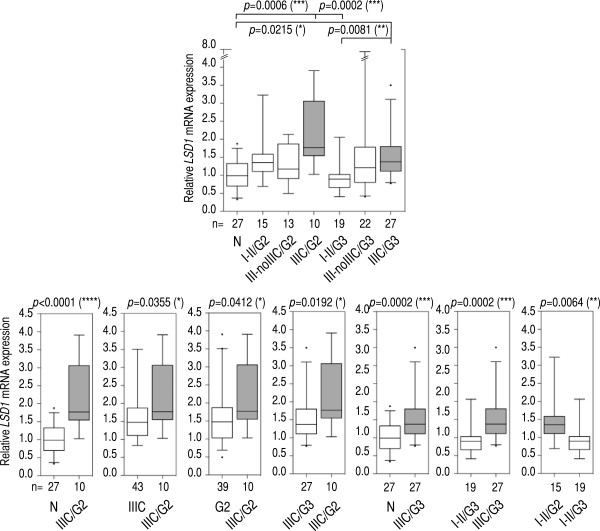
Multi- and pair-comparison statistical tests suggest that a combination of stage IIIC and grade G2 is the diagnosis associated with the highest levels of LSD1 mRNA overexpression in our cohort. Top panel: multiple-comparison analysis of normal tissue (N) and tumors subclassified as stage I or II and grade G2 (I-II/G2) or as stage I or II and grade G3 (I-II/G3); as stage III excluding IIIC and grade G2 (III-noIIIC/G2) or as stage III excluding IIIC and grade G3 (III-noIIIC/G3); and as stage IIIC and grade G2 (III/G2) or as stage IIIC and grade G3 (III/G3). Bottom panels: pair-comparison analyses in normal tissue (N), and stage IIIC and grade G2 (IIIC/G2) tumors (first panel); stage IIIC tumors, and stage IIIC and grade G2 (IIIC/G2) tumors (second panel); grade G2 tumors, and stage IIIC and grade G2 (IIIC/G2) tumors (third panel); stage IIIC and grade G3 (IIIC/G3) tumors, and stage IIIC and grade G2 (IIIC/G2) tumors (fourth panel); normal tissue (N), and stage IIIC and grade G3 (IIIC/G3) tumors (fifth panel); stage I or II and grade G3 (I-II/G3) tumors, and stage IIIC and grade G3 (IIIC/G3) tumors (sixth panel); and stage I or II and grade G2 (I-II/G2) tumors, and stage I or II and grade G3 (I-II/G3) tumors (seventh panel). We applied the Mann–Whitney test in pair-comparison analyses, and the Kruskal-Wallis (non-parametric ANOVA) test followed by post hoc Dunn’s analysis in multiple-comparison analyses (number of comparisons = 21). P-values are shown on top of each panel when significant. Number of specimens in each group is shown at the bottom of each panel. All histological subtypes were analyzed, excluding mucinous. Whiskers in box plots represent 5–95 percentile values, and horizontal lines within boxes represent median values. P-value < 0.05 (*), p-value < 0.01 (**), p-value < 0.001 (***), p-value < 0.0001 (****).